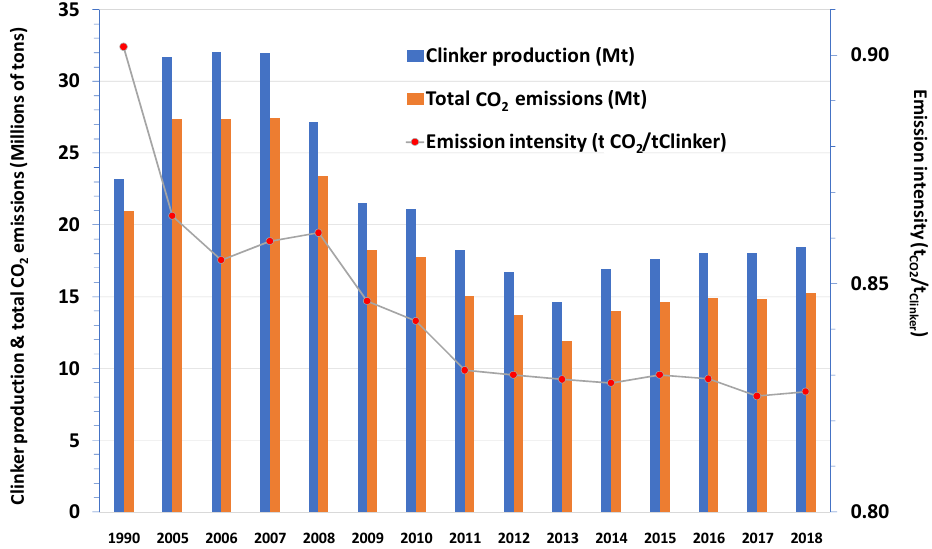
Figure 2. Comparison between the total emission intensity in the Spanish cement industry from 2005 to 2018 plus 1990 and the clinker production and total CO 2 emissions.